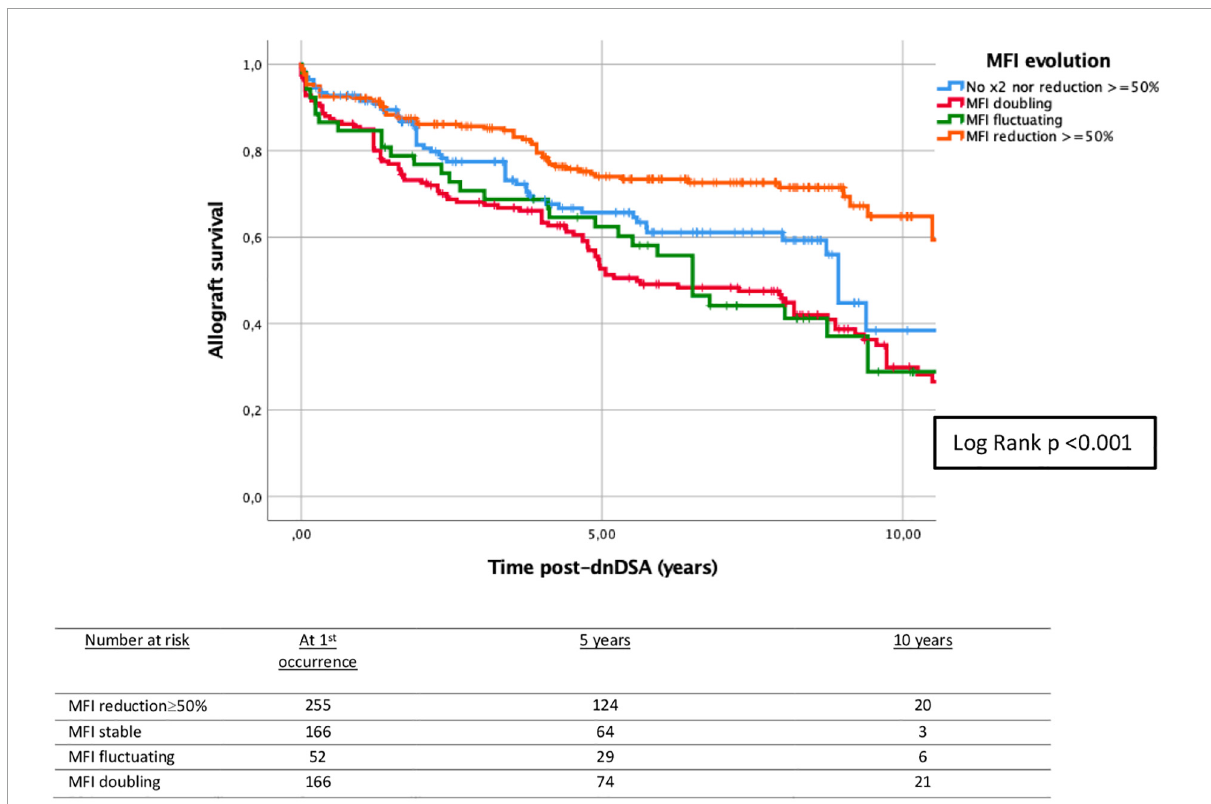
FIGURE4 Kaplan–Meier survival analysis of death-censored graft failure for dnDSA-MFI evolution after the first occurrence of dnDSA. Five-year death-censored allograft survival post-dnDSA: 74.0% ( ± 3.0%) when MFI reduction ≥ 50%; 65.6% ( ± 4.2%) when no MFI reduction ≥ 50% nor MFI doubling; 62.4% ( ± 6.9%) when MFI fluctuating; and 52.7% ( ± 4.0%) when MFI doubling. Log-rank p < 0.001. dnDSA, de novo donor-specific antibodies; MFI, mean fluorescence